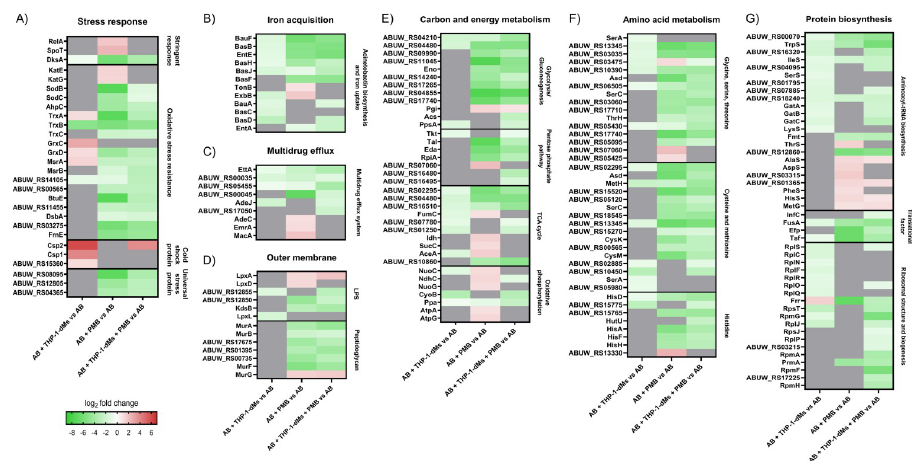
Fig 1. Polymyxins and THP-1-dMs cause unique proteomic changes in A . baumannii . Heatmaps showing protein expression changes of AB5075 in A ) stress response; B ) metal acquisition; C ) multidrug efflux; D ) outer membrane; E ) carbon and energy metabolism; F ) amino acid metabolism; and G ) protein biosynthesis in respective comparison groups. The colour code shows log 2 FC values of differentially expressed proteins with FDR < 0.05 compared to that of untreated controls. Grey indicates protein expression exceeded an FDR of 0.05. Data are presented as mean of three biological replicates per experimental group. AB, wild-type A. baumannii AB5075; PMB, polymyxin B; THP-1-dMs, macrophage-like THP-1